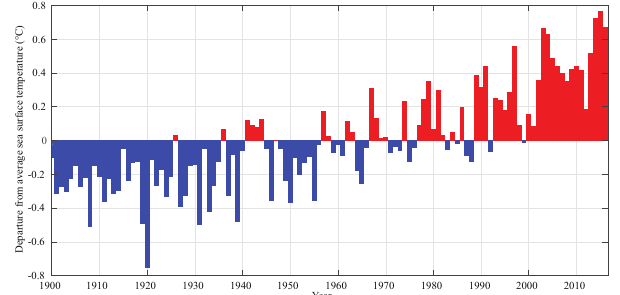
Figure 1. Chukchi Sea continental shelf (64 to 74 ◦ N and 180 to 157 ◦ W) annual sea surface temperature anomaly over the 1900–2016 period of record from the ex- tended reconstructed sea surface temperature (SST) dataset (Smith et al., 2008). The data are publicly available here: https://www.ncdc.noaa.gov/data-access/marineocean-data/ extended-reconstructed-sea-surface-temperature-ersst-v5 (last access: 9 November 2018). Blue bars indicate colder than average temperatures for the given year, whereas red bars indicate warmer than average temperatures. The annual anomalies were computed by subtracting the long-term mean (0.114 ◦ C).